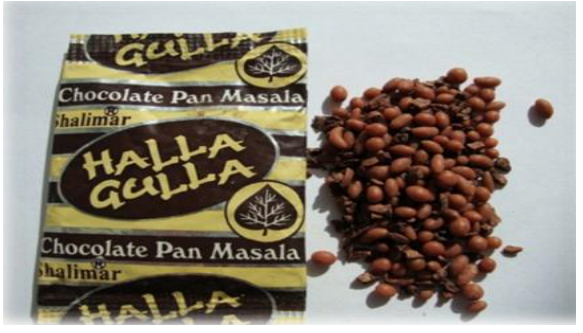
Figure 11. One kind of supari